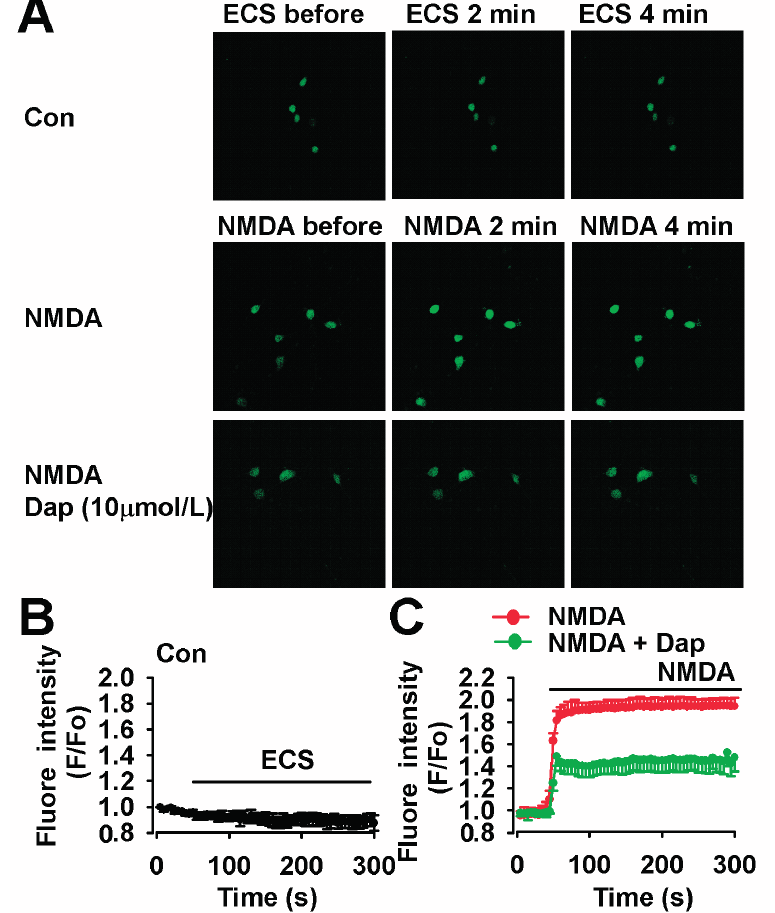
Figure 5. Effects of Dap on the calcium influx. ( A ) The green fluorescence under the laser scanning microscope at different time showed the concentration of calcium in